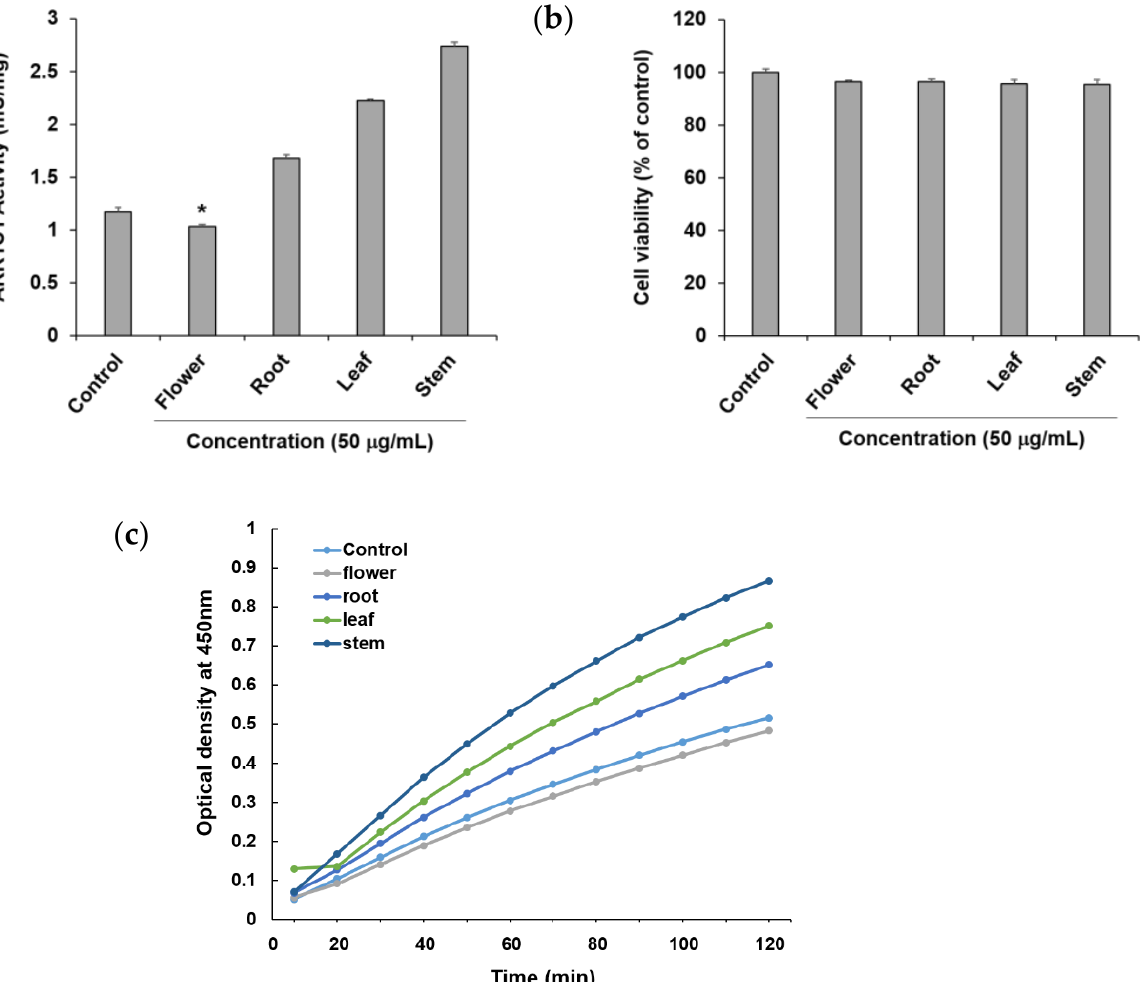
Figure 3. Effects of the methanol extract of four different parts of Peucedanum japonicum (50 μg/mL) ( a ) on Aldo–keto reductase (AKR)1C1 activity, ( b ) cell viability, and ( c ) optical density (OD) over time, in A549 human non-small-cell lung cancer cells. Data are presented as means ± SD of three independent experiments. * p < 0.05 vs. control.